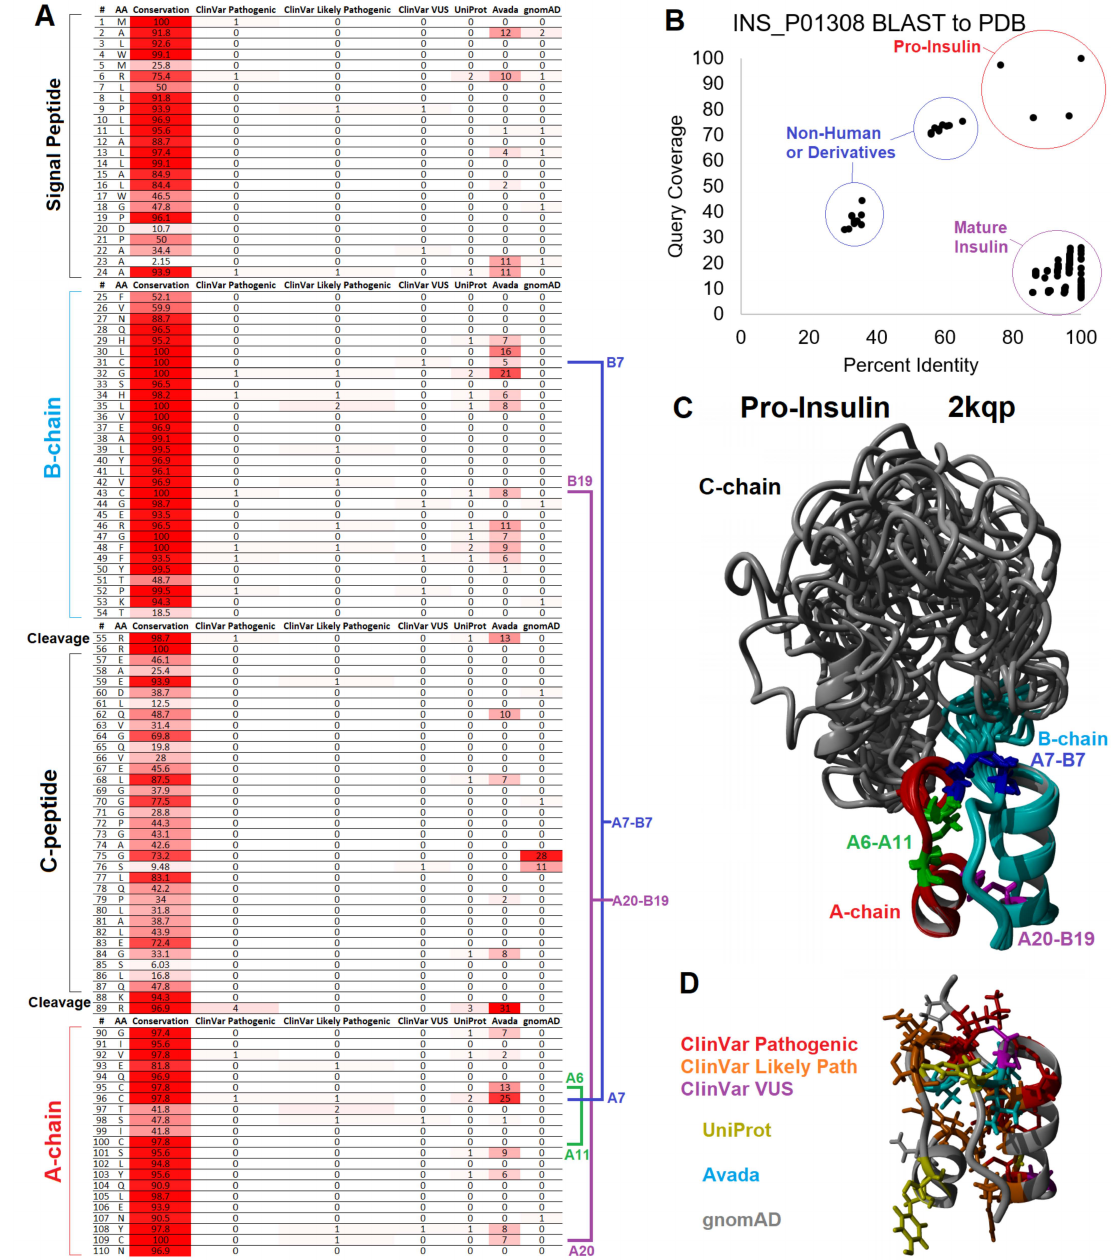
Figure 6. Mapping of variants to insulin structure. ( A ) Table of conservation and missense variants from ClinVar, UniProt, Avada, and gnomAD impacting the preproinsulin molecule listed by amino acid. Cystines involved in disulfide bonding are marked in blue (A7-B7), magenta (A20-B19), and green (A6-A11) with labeling for A- and B-chain numbering. ( B ) BLAST analysis of sequences within the PDB similar to human preproinsulin (UniProt O01308) with the percent identity of the sequence from the structure shown on the x-axis and the coverage of sequence on the y-axis. ( C ) Structure models of human proinsulin from PDB file 2kqp showing the aligned top twenty models. The B-chain is colored cyan, C-chain in gray, A-chain in red, and disulfide bonds as colored in Panel A. ( D ) The A- and B-chain are the same orientation as Panel C but colored for human variants, where red represents ClinVa variants identified as pathogenic, orange represents ClinVar variants identified as likely pathogenic, magenta represents ClinVar variants of uncertain significance (VUS), yellow represents UniProt-annotated variants, cyan represents Avada-annotated variants, and gray represents gnomAD-observed